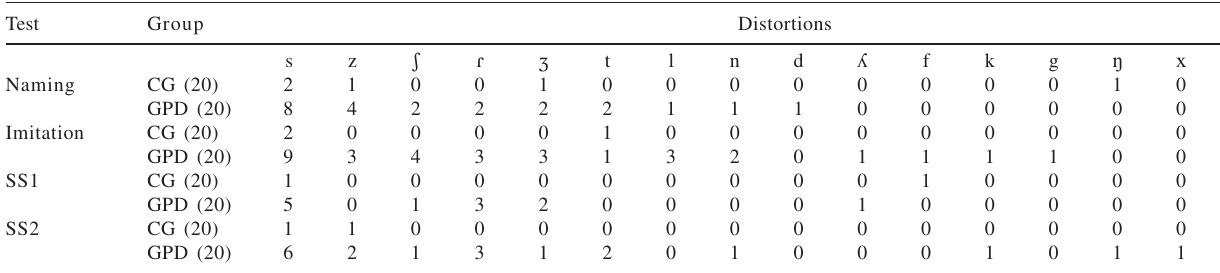
Table 2 - Number of children who presented distortions.